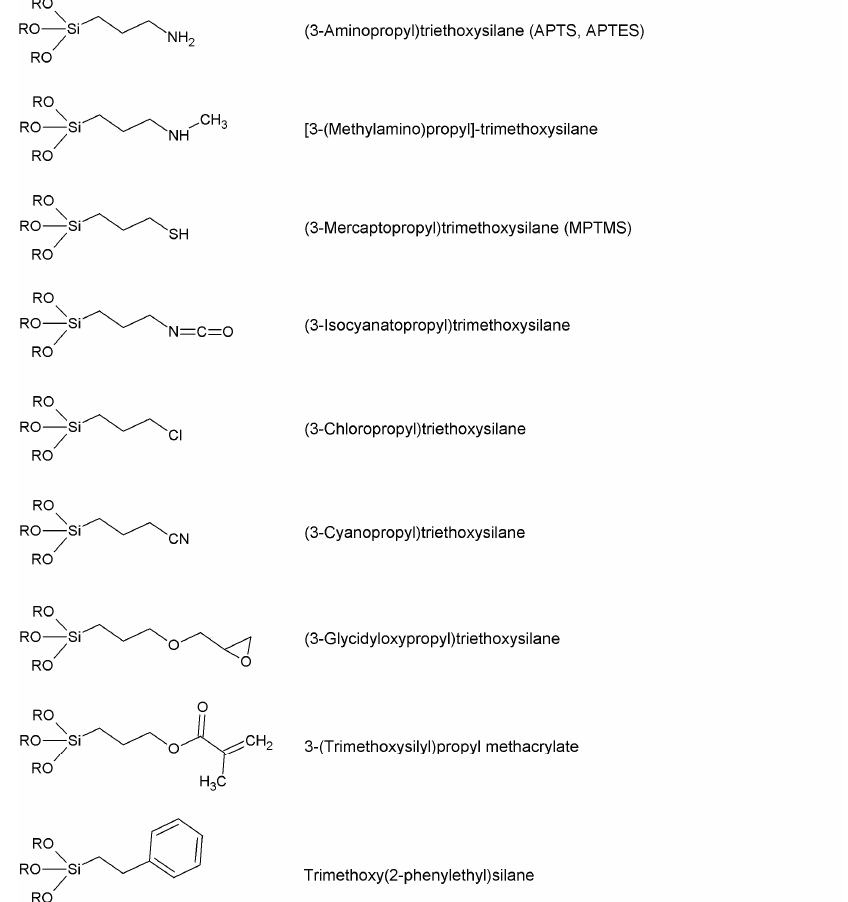
Figure 3. The most widespread organosilanes for the functionalization of inorganic supports during protein